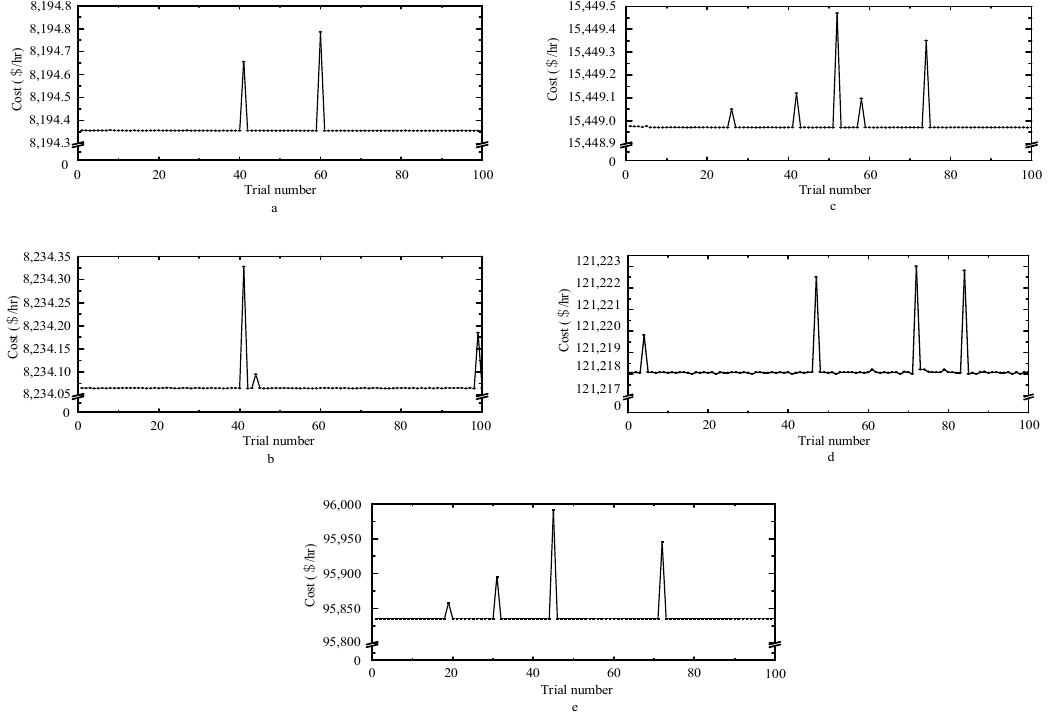
Figure 3. The accuracy of the MIW-PSO: ( a ) first case study; ( b ) second case study; ( c ) third case study; ( d ) fourth case study; ( e ) fifth case